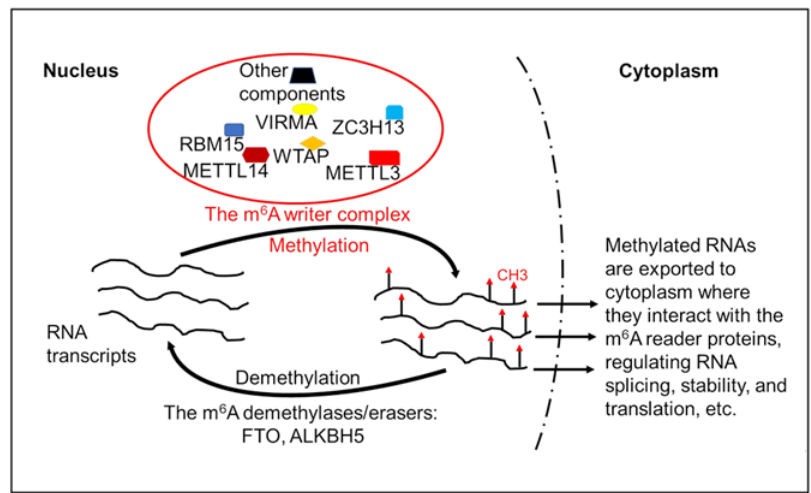
Figure 1. Regulation of RNA transcripts’ m6A modification. The RNA m6A modification is carried out by the m6A writer complex, which consists of multiple components including RNA methyl- transferases and other proteins. The m6A-modified RNA transcripts could be demethylated by the m6A demethylase FTO or ALKBH5. The m6A-modifed RNA transcripts are exported to cytoplasm where they interact with the m6A reader proteins. The interactions between the m6A-modified RNA molecules and their reader proteins regulate RNA splicing, stability, and translation efficiency. METTL3, methyltransferase-like 3; METTL14, methyltransferase-like 14; WTAP, Wilms’ tumor 1- associated protein; VIRMA, Vir-like m6A methyltransferase-associated protein; ZC3H13, zinc finger CCCH domain-containing protein 13; RBM15, RNA-binding motif protein 15; FTO, fat mass and obesity-associated protein; ALKBH5, AlkB homologue 5.